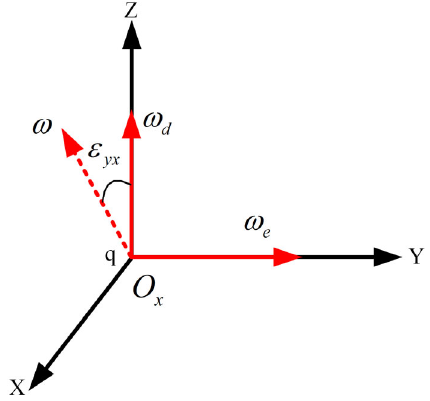
 . Figure 12. The error twist of the error ε yx yx